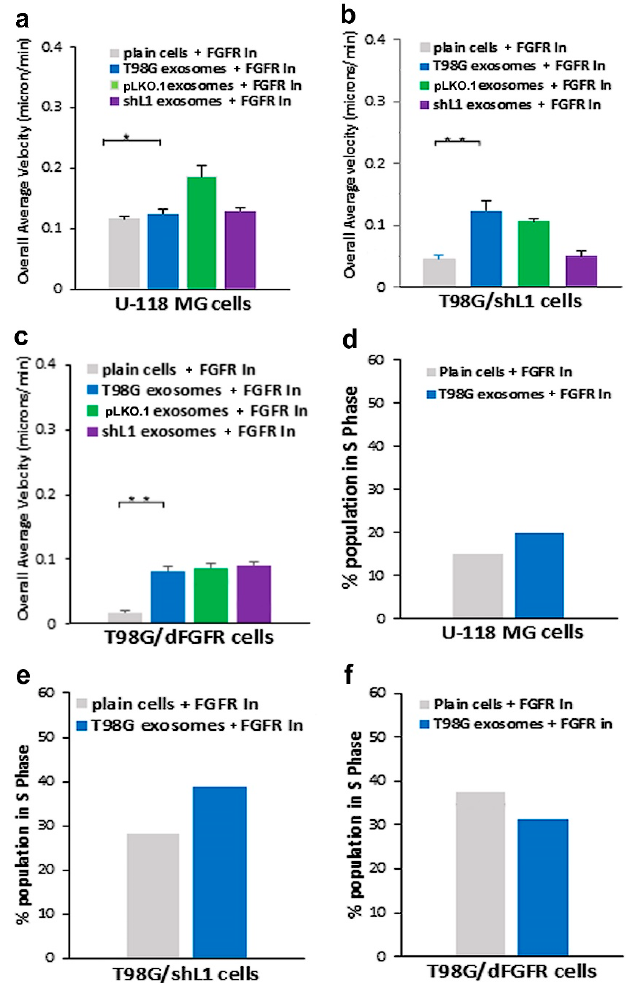
Figure 6. Effects of FGFR inhibitor PD173074 on motility and proliferation. ( a ) Overall average velocities of U-118 MG cells treated with the FGFR inhibitor. ( b ) Overall average velocities of T98G/shL1 cells treated with inhibitor. ( c ) Overall average velocities of T98G/dFGFR cells treated with inhibitor. ( d ) U-118 MG cell proliferation (% S phase population) with the addition of the inhibitor. ( e ) T98G/shL1 cell S phase population when treated with inhibitor. ( f ) T98G/dFGFR cell S phase population when treated with inhibitor, * p < 0.05, ** p < 0.01.